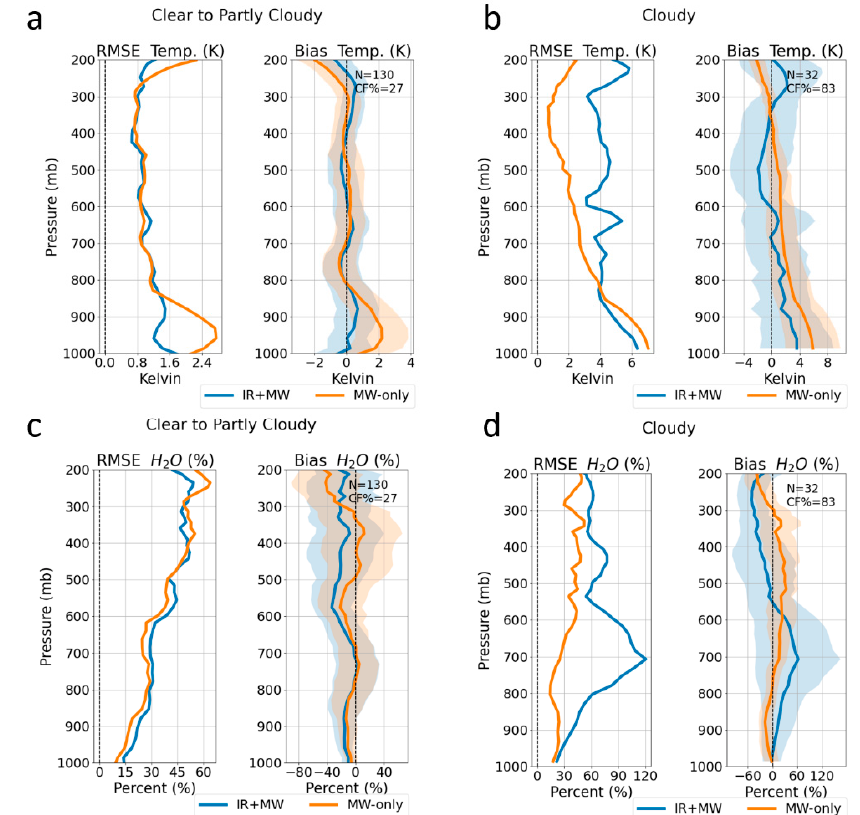
Figure 4. RMSE, bias, and standard deviation of IR + MW and MW-only retrievals for ( a ) temperature (K) over clear to partly cloudy scenes, ( b ) temperature (K) over cloudy scenes, ( c ) water vapor (%) over clear to partly cloudy scenes, and ( d ) water vapor (%) over cloudy scenes. Profile count (N) and cloud fraction (CF%) is indicated in the top right corner.